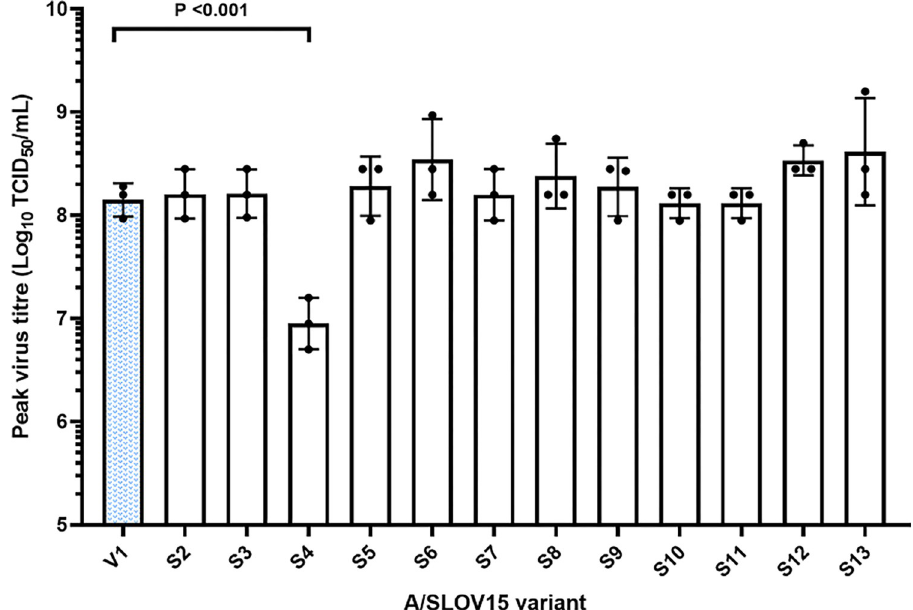
fluid collected every 24-hours post-infection. Mean peak titre achieved by each A/SLOV15 variant across three independent experiments is expressed by the columns. Symbols depict the individual peak titres from each experiment and error bars indicate standard deviation. A/SLOV15 V1 is shown in blue. One-way ANOVA with a Dunnett’s multi- comparison test was conducted to compare A/SLOV15 V1 to all other A/SLOV15 variants. Significant differences are indicated by P values. A/SLOV15 mutants S2-S13 were generated by introducing the following substitutions to wt A/ SLOV15 HA (V1) sequence: S2: N125D; S3: D127E; S4: D222G; S5: R223Q; S6: N125D, D127E; S7: D127E, D222G;